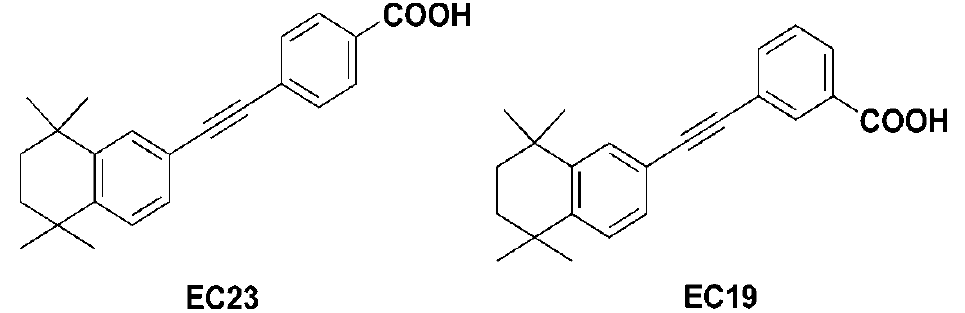
Figure 1. Structures of EC-synthetic retinoic acid analogues [26].